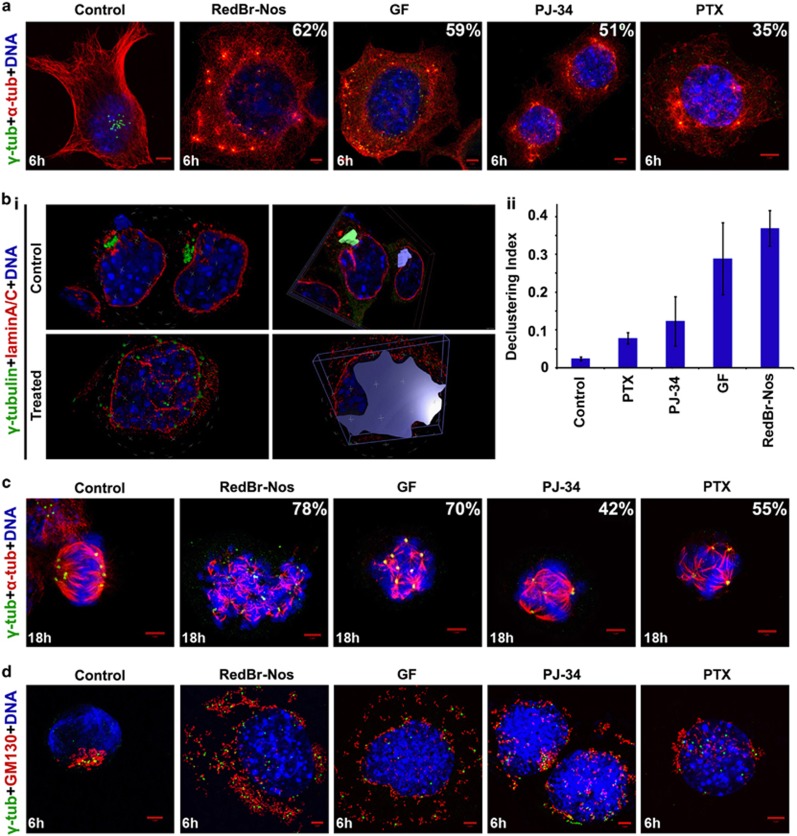
Interphase declustering induced by centrosome-declustering agents. (a) Confocal micrographs showing interphase declustering induced by 6-h treatment with RedBr-Nos (10 μM), Griseofulvin (50 μM), PJ-34 (25 μM) and Paclitaxel (0.1 μM). The percentages indicate proportion of interphase cells with declustered centrosomes. (bi) 3-D representation and quantitative volume analysis of control and drug-treated interphase cells using the Volocity 6.3 software. Cells were co-immunostained for lamin A/C (red) and γ-tubulin (green), and z-stacks were acquired with a 0.35 μm z-step. Z-stack slices were then used to construct a 3-D image, and ROIs were defined to generate DI measurements. (bii) Quantitative bar graph representing the DI of the four drugs. P<0.05. (c) Confocal micrographs showing spindle multipolarity induced by 18h treatment with declustering agents RedBr-Nos (10 μM), Griseofulvin (50 μM), PJ-34 (25 μM) and Paclitaxel (0.1 μM). Cells were co-immunostained for α-tubulin (red) and γ-tubulin (green). The percentages indicate proportion of mitotic cells with declustered centrosomes. (d) Confocal micrographs showing Golgi dispersal concomitant with interphase declustering upon 6-h treatment with all the four declustering agents at the stated concentrations. Cells were co-immunostained for GM130 (red) and γ-tubulin (green). DNA was DAPI (4,6-diamidino-2-phenylindole) stained. Scale bar, 5 μm